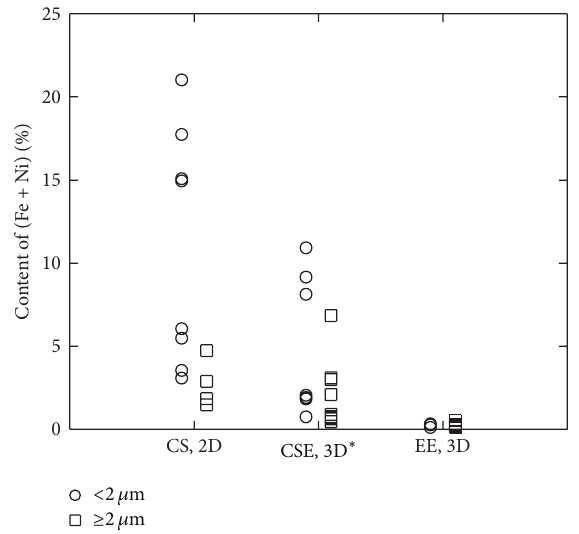
Figure 5: Effect of the metal matrix (Fe + Ni content) on analysis of alumina inclusions in an Fe-10 mass% Ni alloy for different evaluation methods.